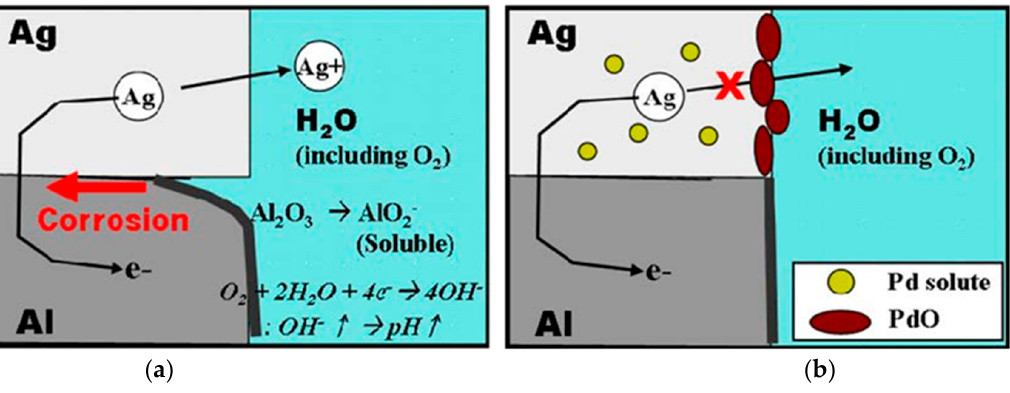
Figure 15. Mitigation mechanism of corrosion: ( a ) bare Ag wire; ( b ) Ag-3Pd alloy wire (Effect on Pd alloying-Ag migration model) [163]. Copyright, 2012, Springer Nature.